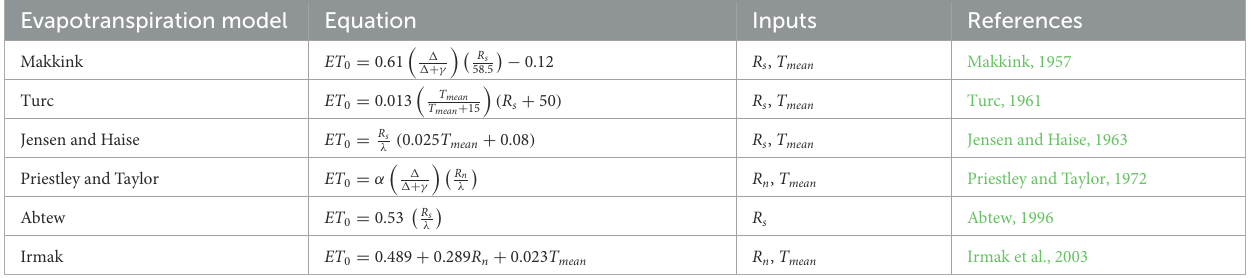
TABLE 2 Radiation-based ET 0 models.